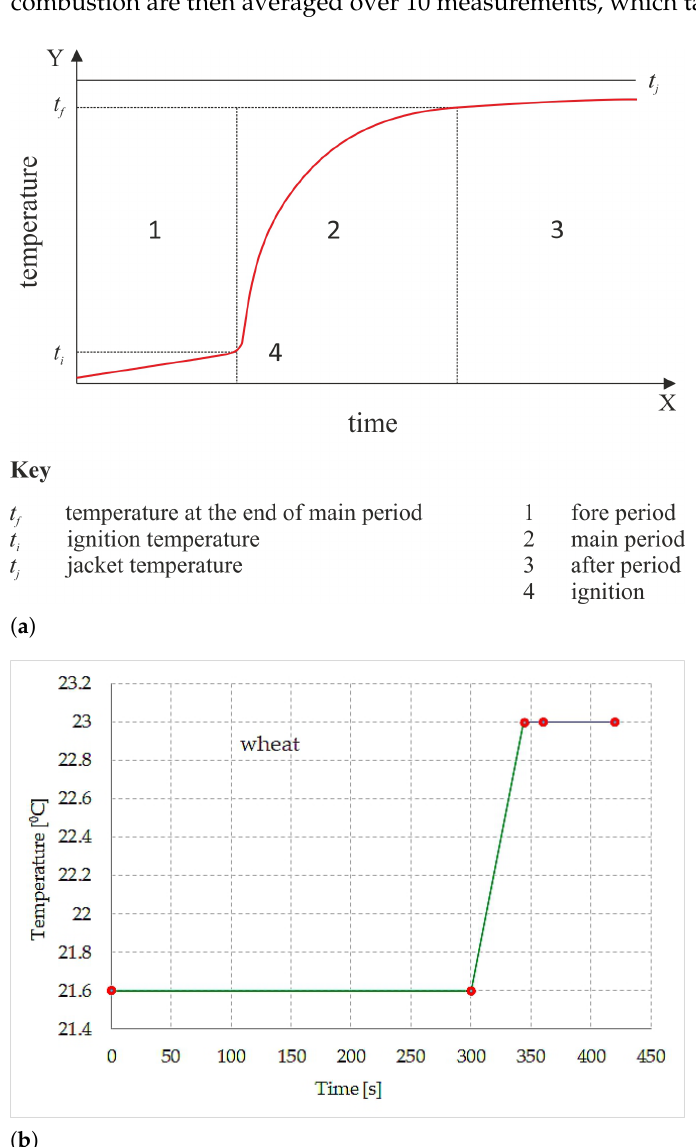
Figure 1. Time-temperature curve of the combustion process: ( a ) illustrative model of the time- temperature curve with three characteristic temperature points, t i , t j and t f (explanations on the legend), according to EN ISO 18125:2017-07; ( b ) exemplary time-temperature curve obtained for 100% wheat-pressed material (biofuel type